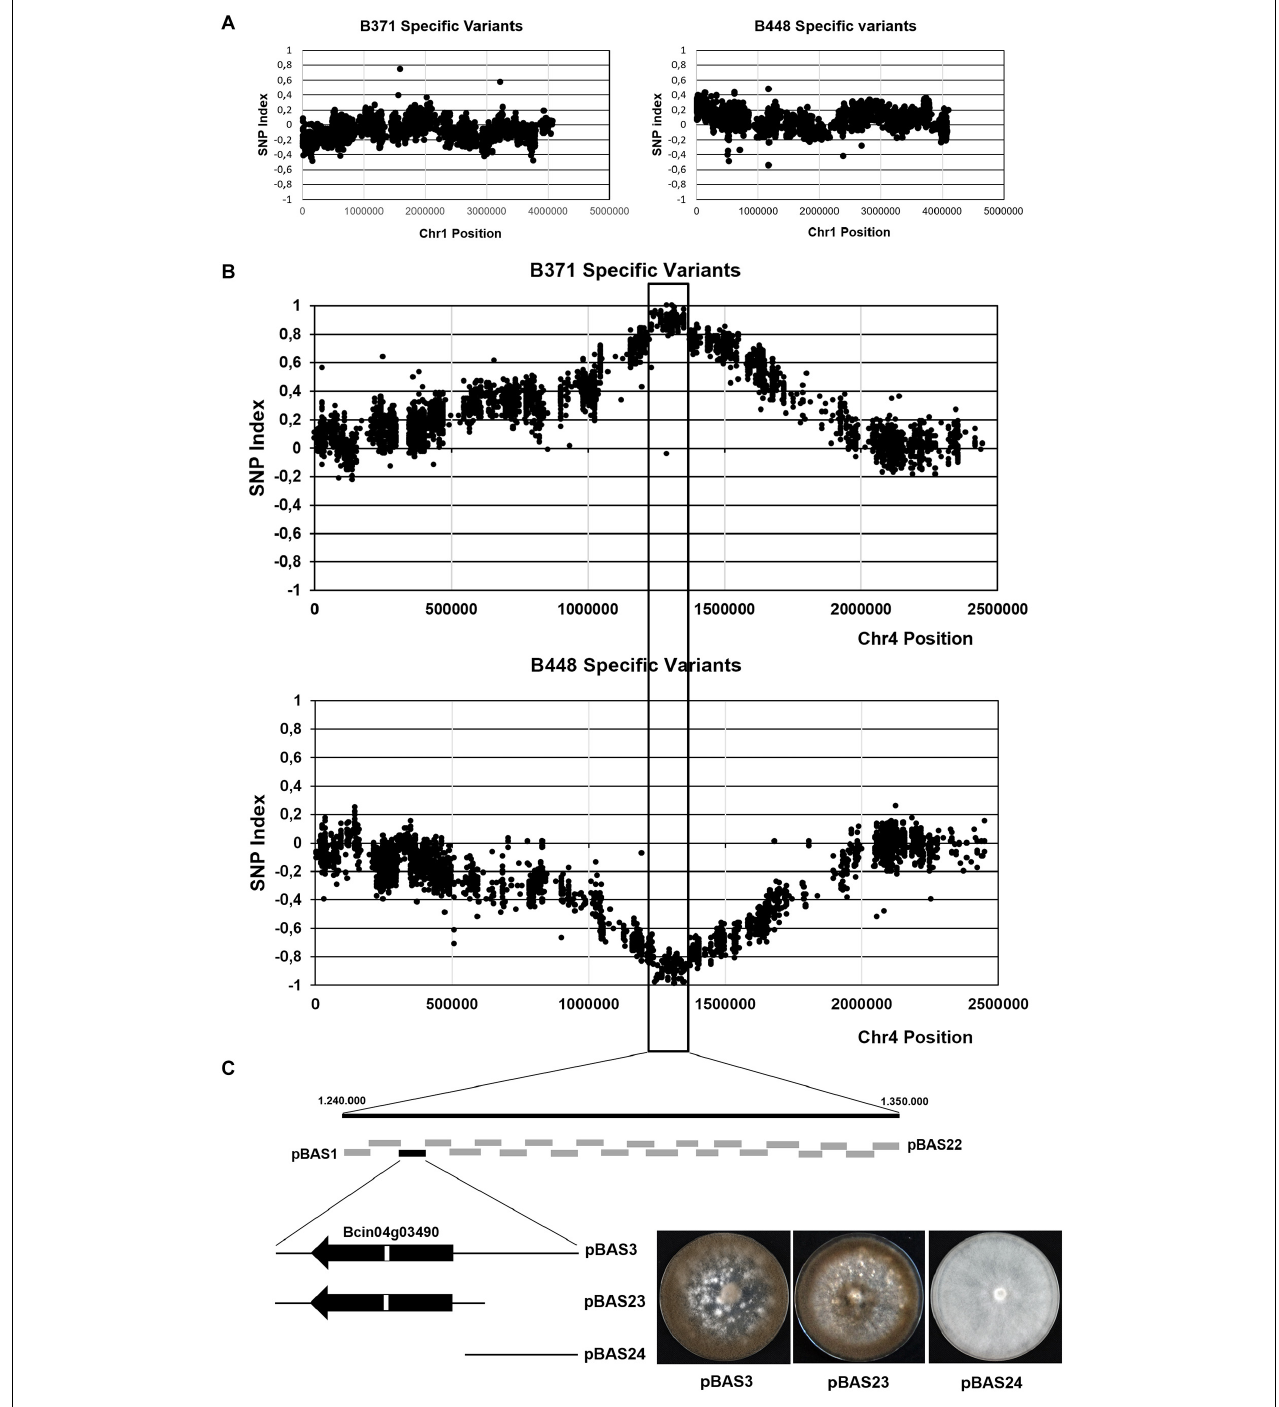
FIGURE 3 | Mapping the major effect gene controlling development and pathogenicity in cross B448 x B371 by BSA. Plots of the distribution of frequencies of the polymorphisms specific of isolate B371 or specific of isolate B448 in Chr1 (A) and in Chr4 (B) . In each plot the x -axis represents the coordinates of the B05.10 isolate chromosome, used as the reference. The y -axis represents the SNP index value of each polymorphism. The vertical lines mark the region where the SNP index reaches values close to (+ 1) for B371 specific variants and close to (-1) for B448 specific variants. (C) Fine mapping by functional complementation. Boxes represent DNA fragments derived from the parental isolate B448 Chr4 in the region delimitated by BSA subcloned in plasmid pWAM6. The black box represents the clone which restored the wild type phenotype upon transformation of isolate B371. The fragment in pBAS3 was further subcloned in plasmids pBAS23 and pBAS24 (see text). The images show representative transformants obtained with the indicated plasmids cultured during 14 days in MEA plates at 22 ◦ C and dark conditions.